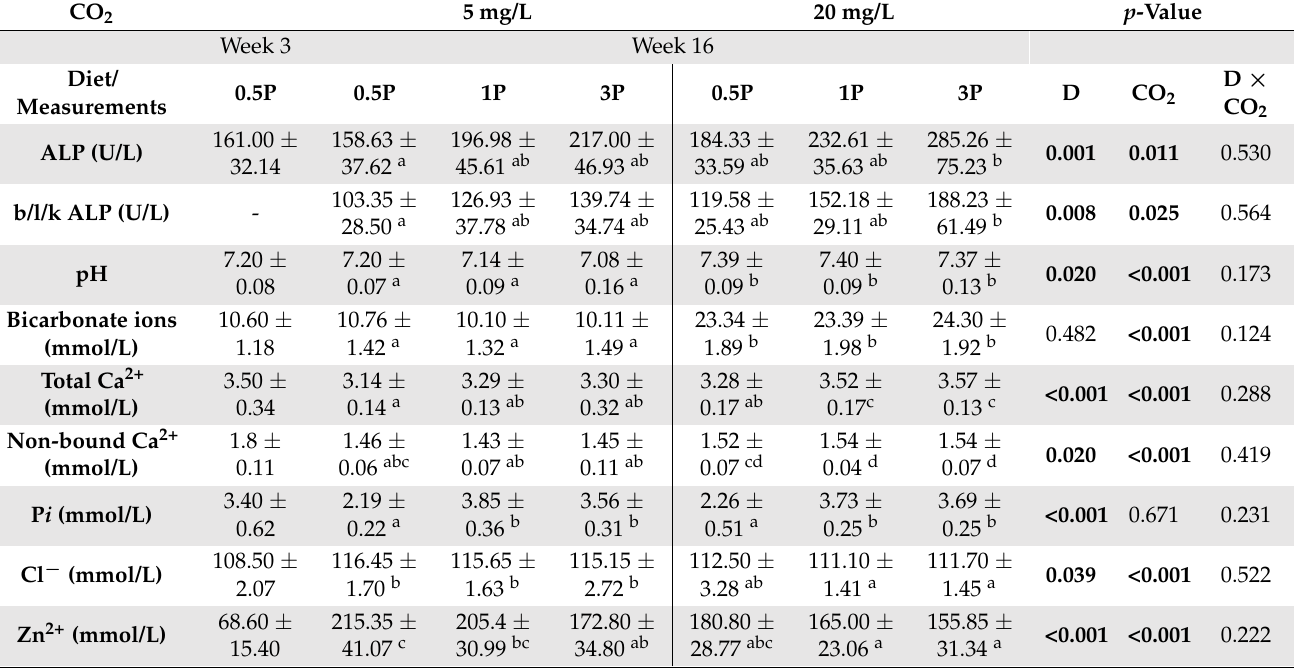
Table 7. Blood plasma analysis (Konelab). Listed values for different plasma alkaline phosphatase (ALP), bone/liver/kidney ALP (b/l/k ALP), pH, bicarbonate ions, total and non-bound Ca 2+ , P i , Cl − , and Zn 2+ of Atlantic salmon at weeks 3 and 16 fed different levels of total phosphorus (P) 0.5P (6.3 g/kg), 1P (9.0 g/kg), and 3P (26.8 g/kg) and reared in conditions with no CO 2 injected (5 mg/L) or with injected CO 2 (20 mg/L). The statistically significant differences among groups (within a row) are indicated by different lowercase superscript letters. If none of the letters are the same, differences are significant. The significant values ( p ) for CO 2 , diet (D), and their interaction are indicated. 5 mg/L